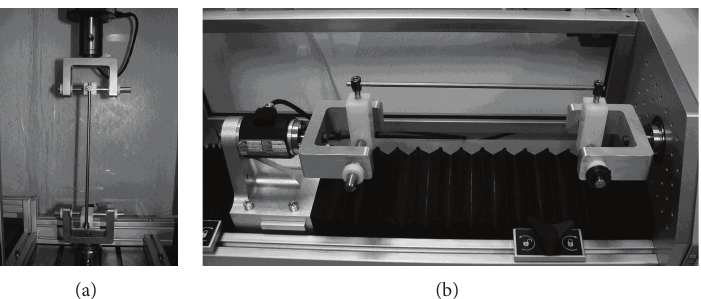
Figure 3: Set-up for testing. (a) Distraction MTS RT/50 Electromechanical Test. (b) Torsion MTS Bionix Electromechanical Torsion Test Frame (MTS Corp., Eden Prairie, MN).